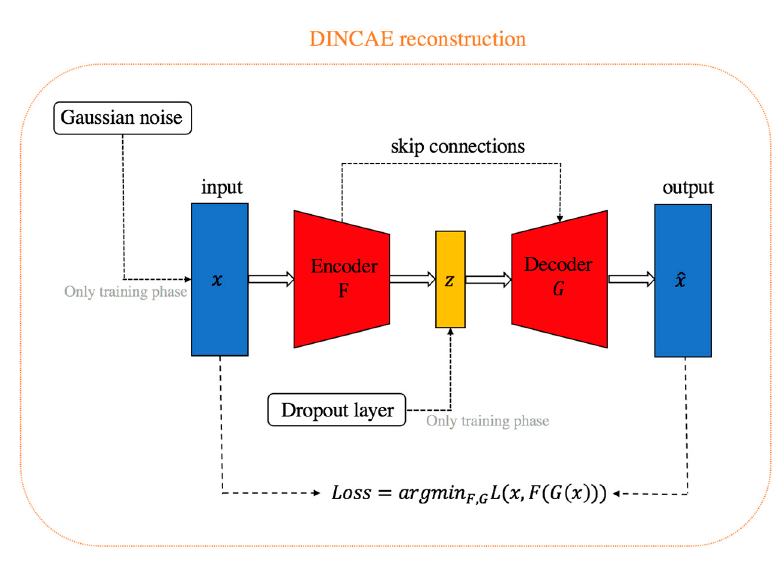
Figure 4. Architecture of the DINCAE model.